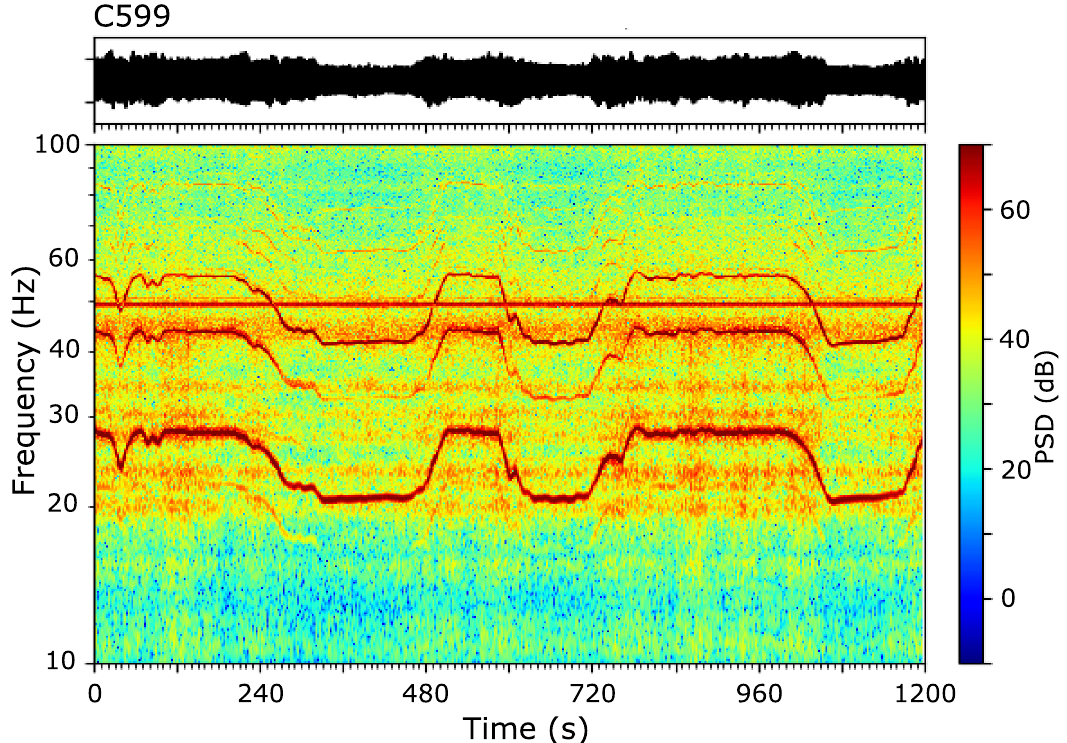
Figure 9. Seismic record and corresponding spectrogram for a 20 min long time interval at station C599. Large energy harmonics with varying frequency are related to the rotation of the WT blades, while the harmonic bands at constant frequencies are related to the oscillations of the WT